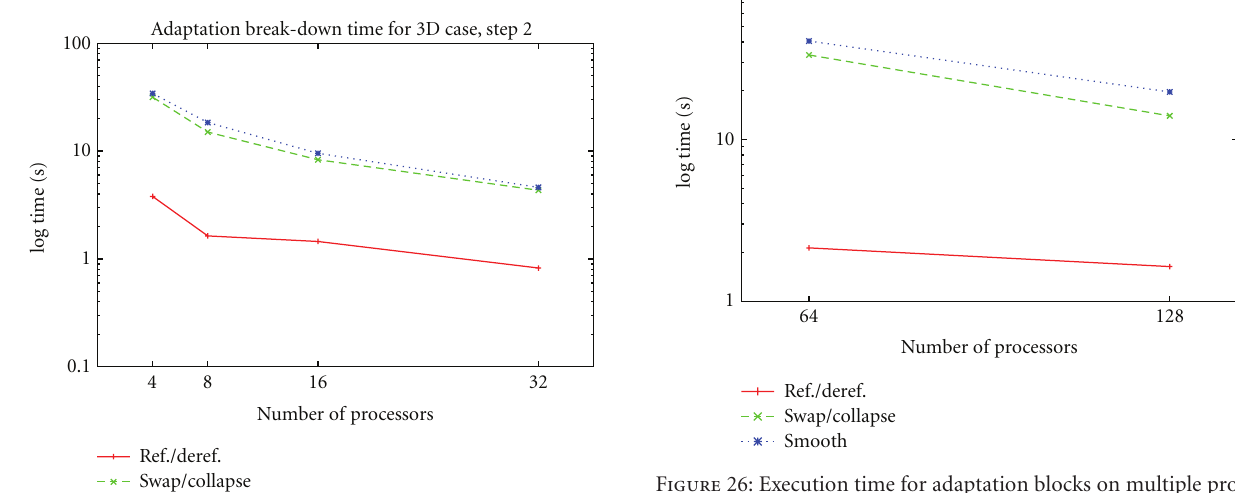
Figure 26: Execution time for adaptation blocks on multiple proc- essors. 3D wedge, one adaptation step after